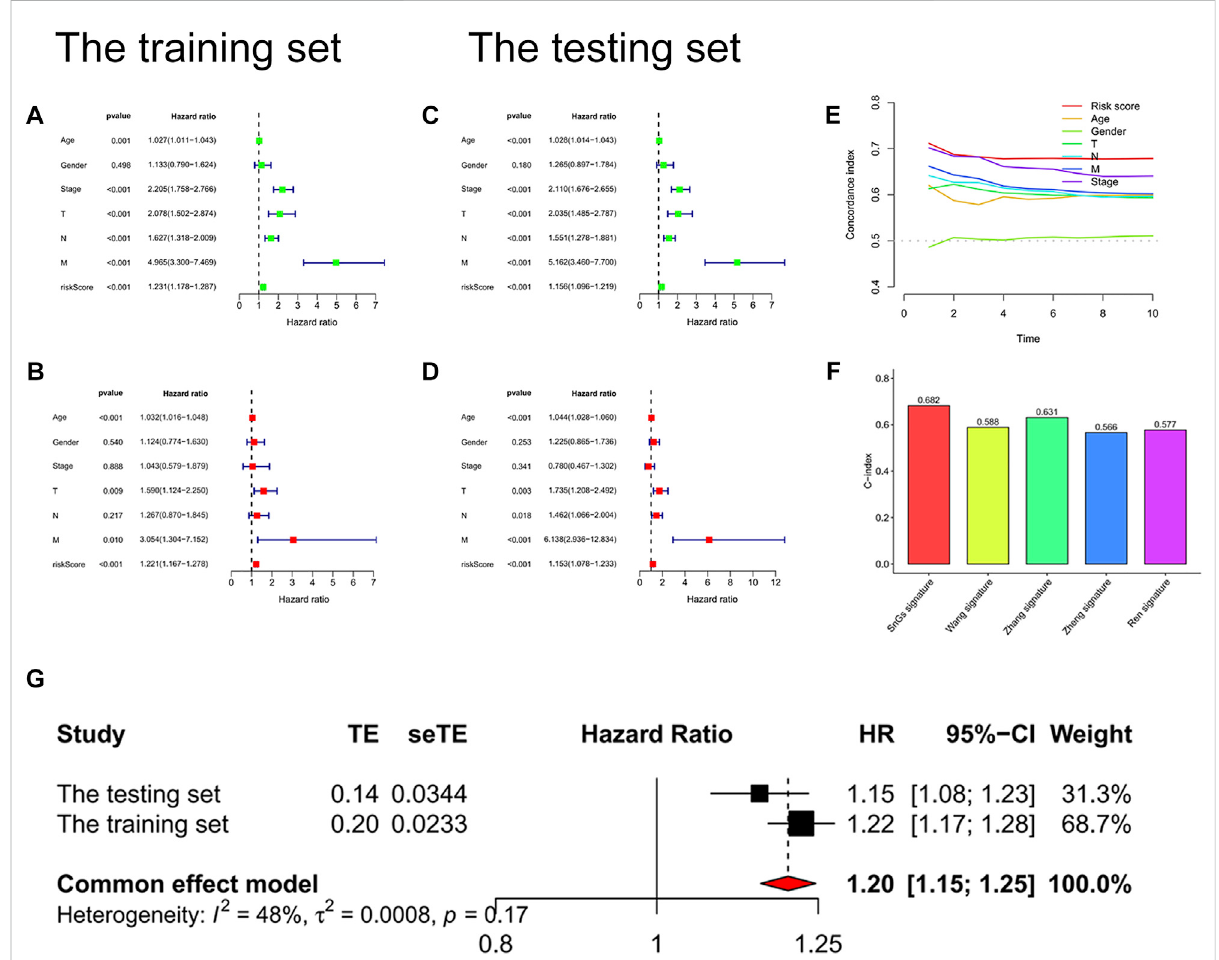
FIGURE 5 Validation of the risk score signature. (A) Univariate Cox regression analysis of the training set. Risk scores, p < 0.001. (B) Multivariate Cox regression analysis of the training set. Risk scores, p < 0.001. (C) Univariate Cox regression analysis of the testing set. Risk scores, p < 0.001. (D) Multivariate Cox regression analysis of the testing set. Risk scores, p < 0.001. (E) C-index curves. C-index value of risk scores was higher than other clinical characteristics (age, gender, pathological stage, T stage, N stage, and M stage). (F) Histogram for signature comparison with